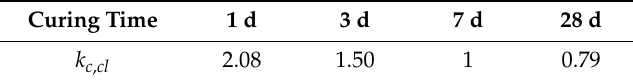
Table 8. Characteristic values of the curing factor k c , cl .